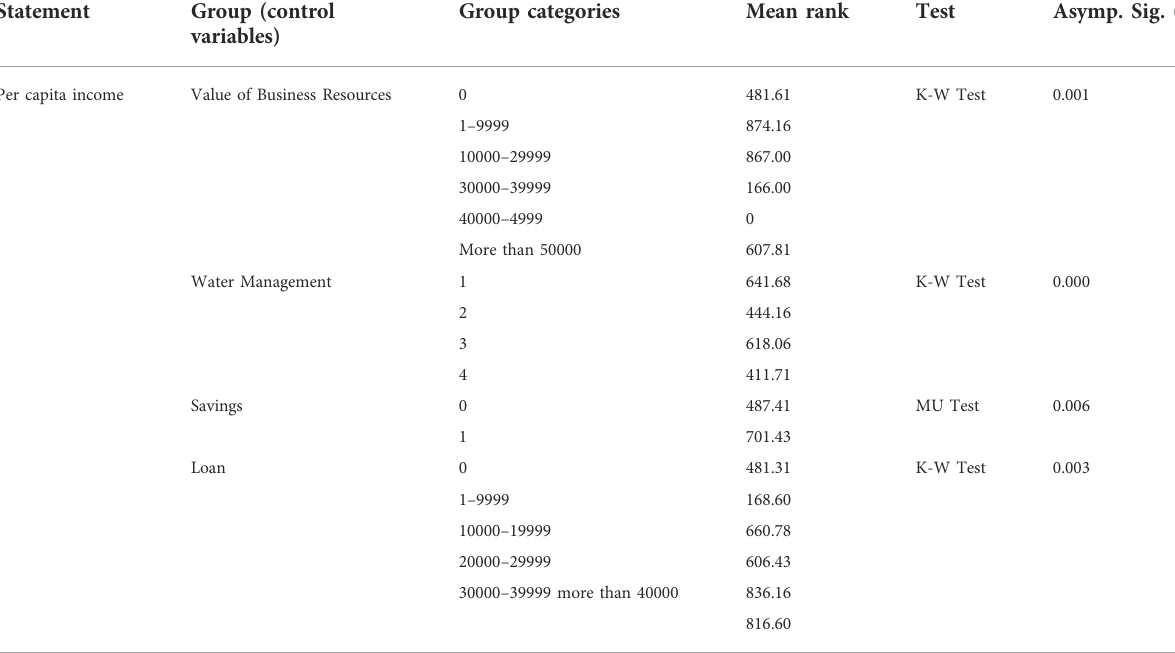
TABLE 9 Signi fi cance of business resources, water savings, and loans on the per capita income from the previous year.